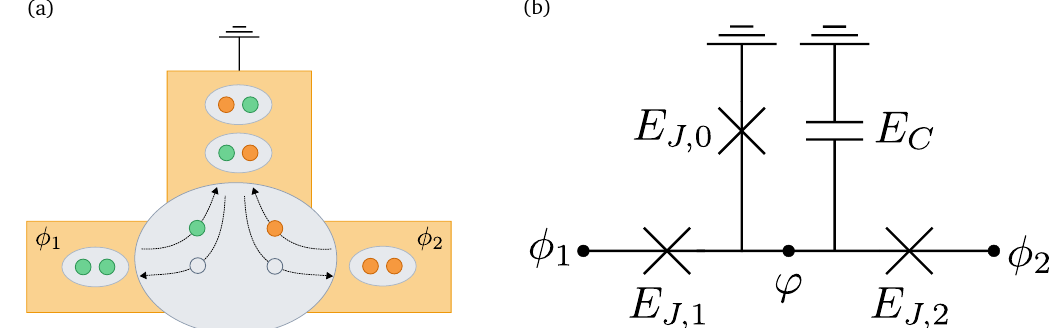
Figure 1: Superconducting devices that carry multiplet supercurrent at com- mensurate DC voltages. (a) A high transparency three-terminal Joseph- son junction supports multiplet supercurrent through non-local Andreev pro- cesses. When voltages applied to terminals 1 and 2 satisfy V ased terminal may transfer one Cooper pair to the grounded terminal through crossed Andreev reflections, resulting in quartet supercurrent. (b) A Joseph- son tunneling circuit also supports multiplet supercurrents. Even when the central island has a large charging energy, multiplet supercurrent still flows despite being carried only by single Cooper pair